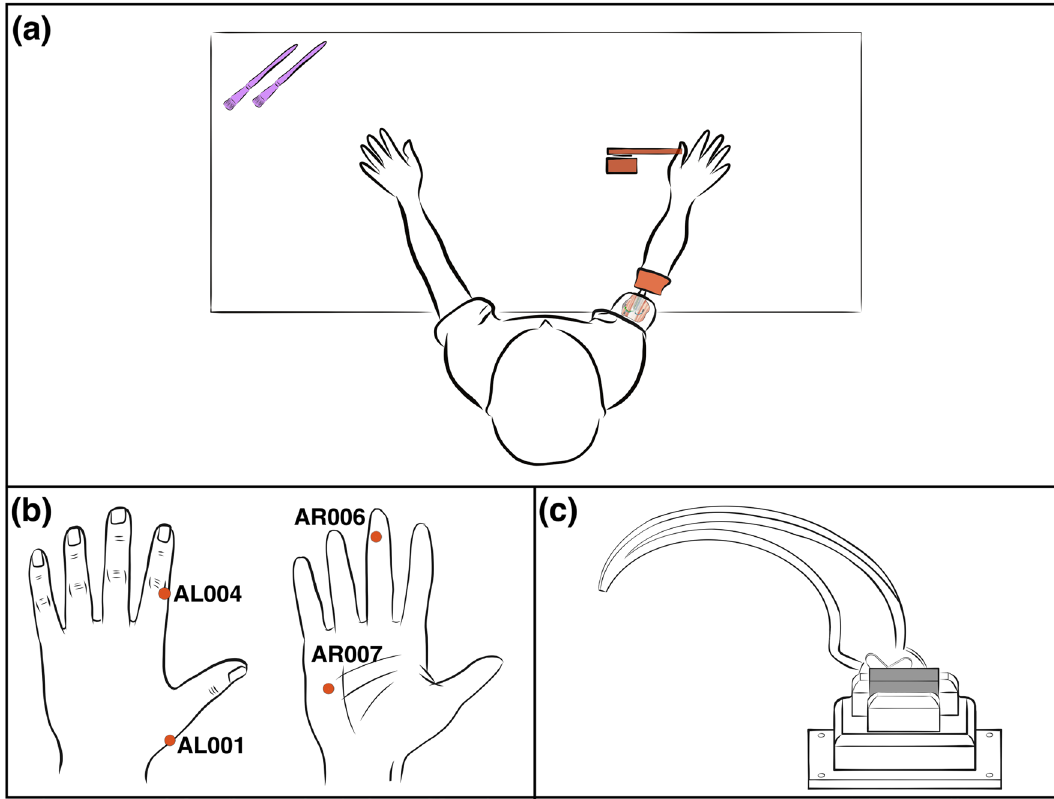
Figure 1. Experimental setup for participants with limb loss at the transhumeral level. ( a ) The prosthesis including the stimulation unit was connected directly to the implanted neuromusculoskeletal interface to provide neural sensory stimulation. A 3D printed tapper touched the participants’ prosthesis on the locations where the participants reported the origin of the perceived neural stimulation. ( b ) Reported perception locations in the phantom hand now occupied by the prosthetic hand ( c ) 3D printed tapper, actuated by a servomotor (grey).